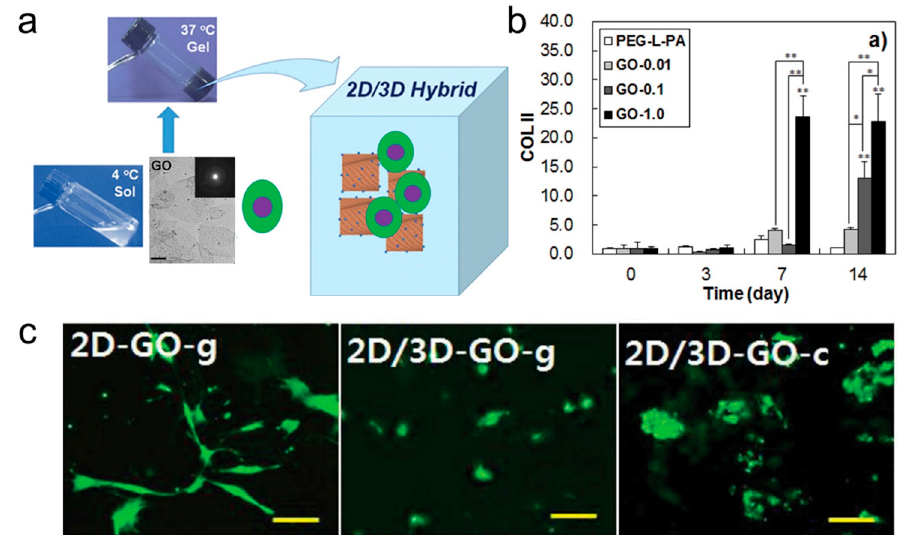
Figure 10. ( a ) Schematic of the 2D/3D thermogel system for culturing TMSCs; ( b ) Expression of COL II at different GO concentrations, * or ** on the bar graph indicates the significance of the 2D/3D hybrid system compared with the PEG-L-PA 3D culture system; ( c ) Cell morphology after 14 days of cell culture. Left: 2D culture with GO, middle: 3D culture with GO/PEG-L-PA, and right: 3D culture with GO/PEG-L-PA and enriched with TGF- β 3. The scale bar is 100 μ m (reproduced with permission from [45]).